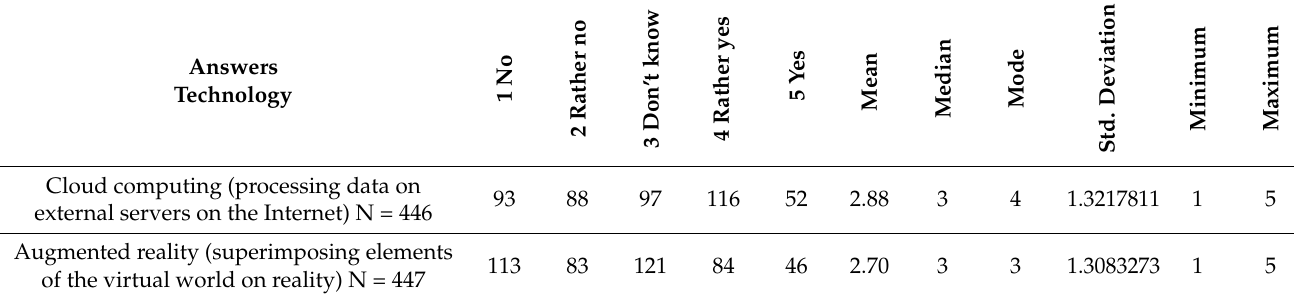
Table 2. Summary of responses regarding general knowledge of specific Industry 4.0 technologies and basic statistics.